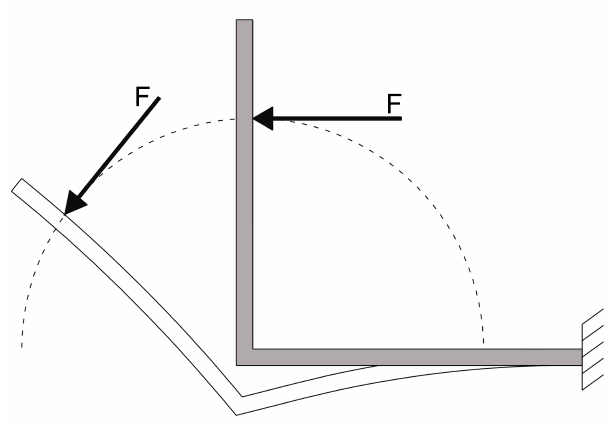
Figure 1. The base case: a creased sheet of material set to a 90 de- gree angle and cantilevered. A displacement load is applied to the initial state (shaded), causing it to deflect to the final state (not shaded). The displacement follows an arc centered at the initial lo- cation of the crease.